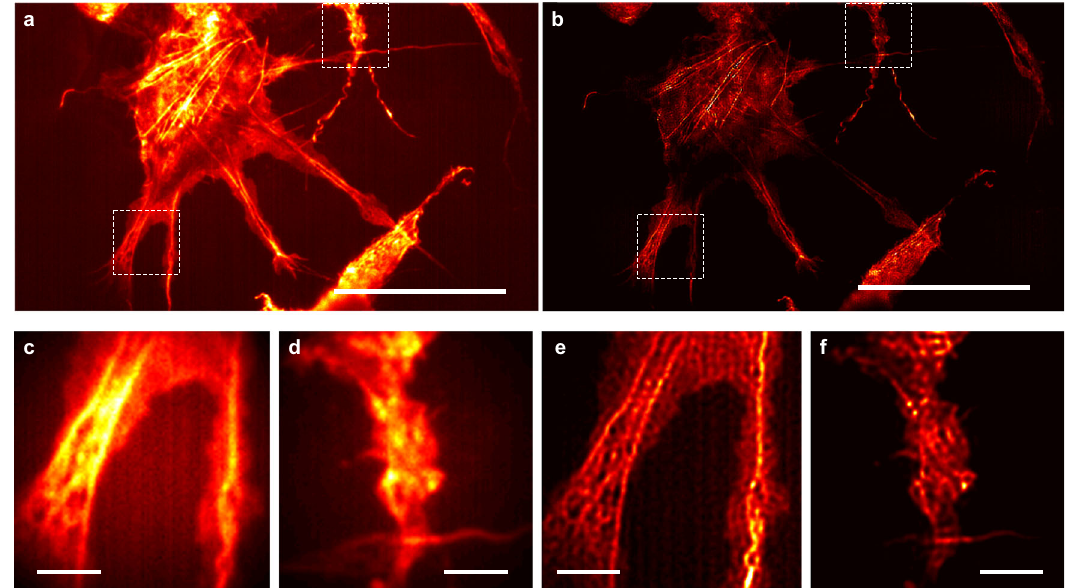
Fig. 5 Speckle-MAIN imaging of Cos-7 cells. a Diffraction-limited image. Scale bar: 20 μ m. Objective lens: 40 ×/0.6 NA. b Reconstructed speckle-MAIN image. c , d Zoom-in view of the white box area in ( a ). e , f Zoom-in view of the white box area in ( b ). Scale bar: 2 μ